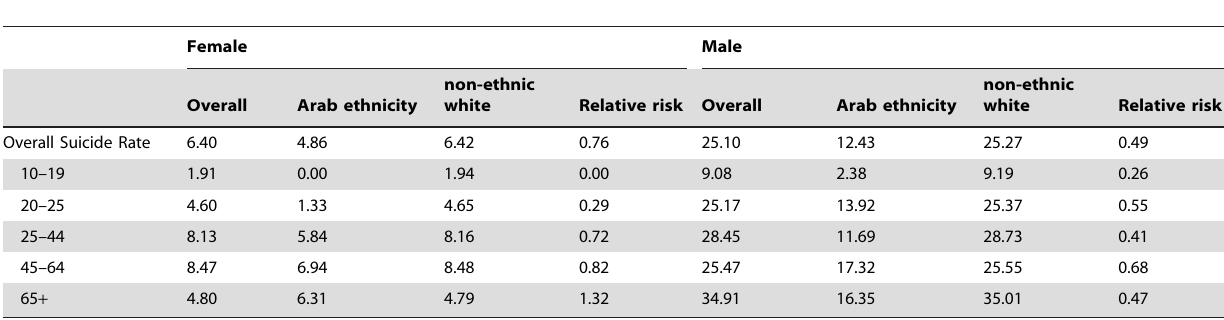
Table 2. Age-adjusted suicide rates (per 100,000 per year) by ethnicity and gender, as well as relative risks of suicide comparing Arab ethnicity to non-ethnic whites aged 10 and older in Michigan,